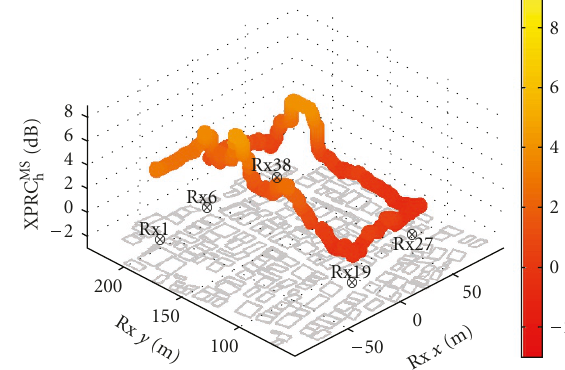
Figure 32: XPRC BS